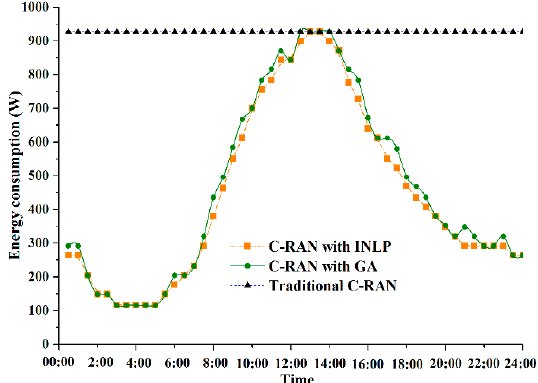
Figure 4. Energy consumptions of fronthaul with different methods.